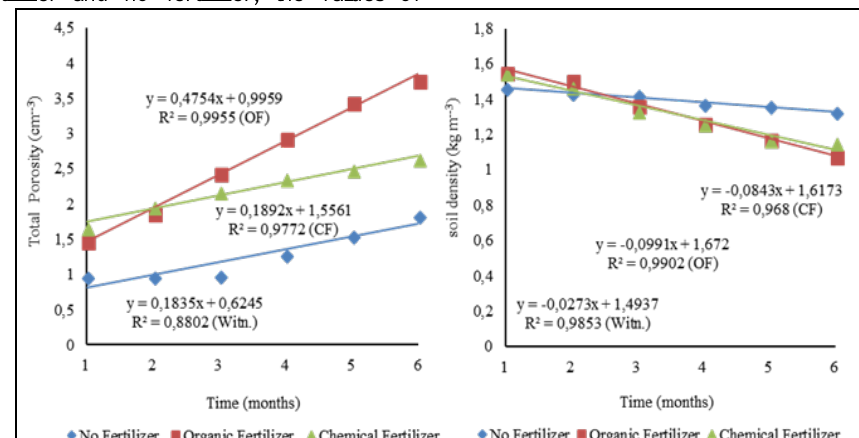
Figure 8: Total porosity and density soil in function of doses of compound organic (1.25 kg ha -1 ), chemical fertilizers (98.6 kg ha -1 of urea, 118.04 kg ha -1 of TSP and 93.05 kg ha -1 KCl) and no fertilizer during the six months of research. Source: Authors, (2018).